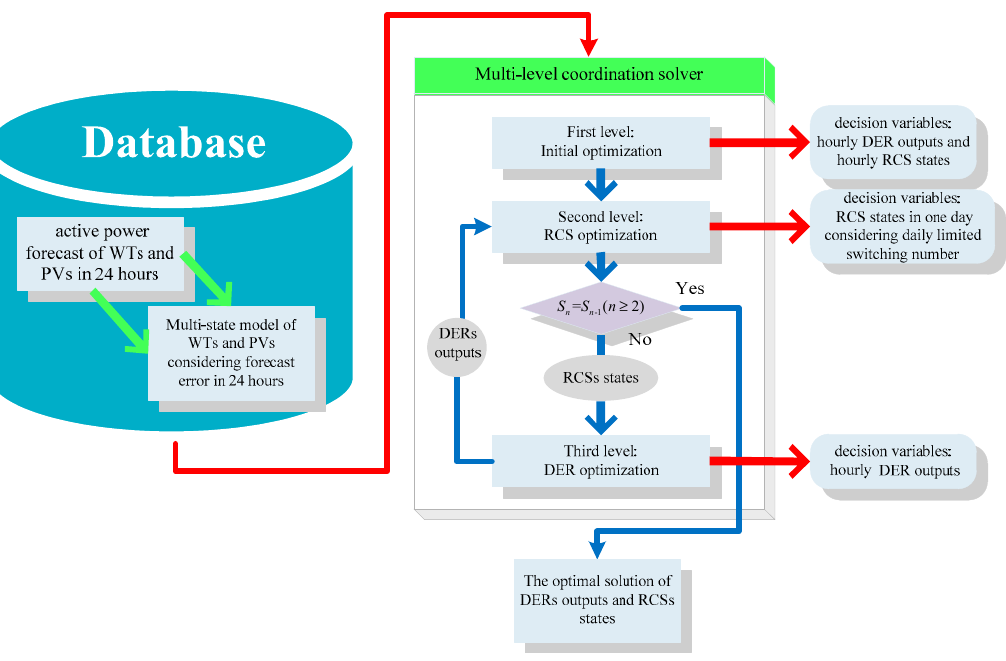
Figure 1. The flow chart of the hierarchical coordination optimization. WTs: wind turbines; PVs: photovoltaics; DERs: distributed energy resource; RCSs: remotely controlled switches.